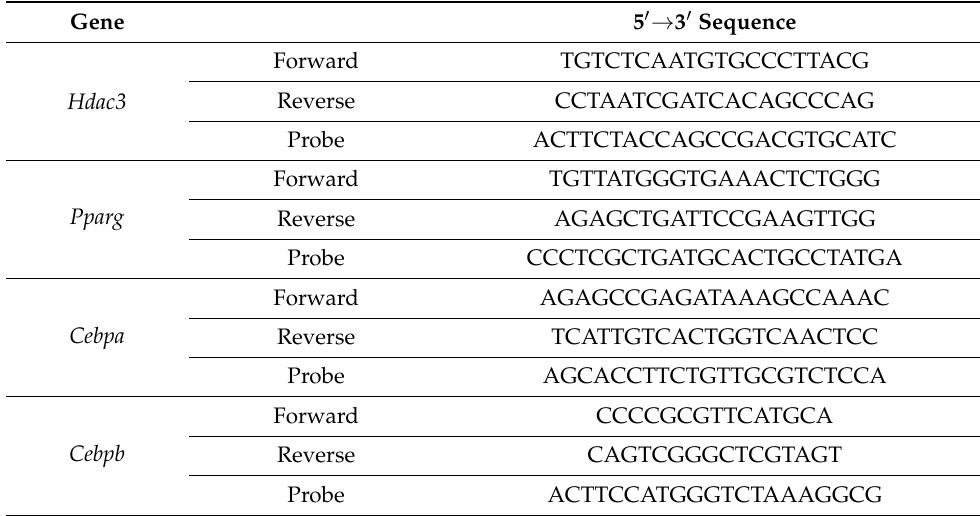
Table 1. Sequences of primers and probes used for gene expression and mtDNA quantification